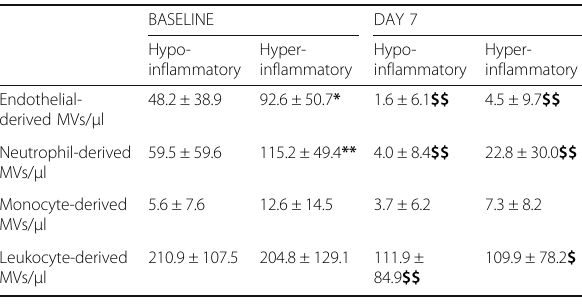
Table 1 (abstract 000889). Mean±SD. * p<0.05, ** p<0.01 vs hypo- inflammatory; $ p<0.05, $$ p<0.01 vs corresponding baseline by t-test or Mann-Whitney U test.